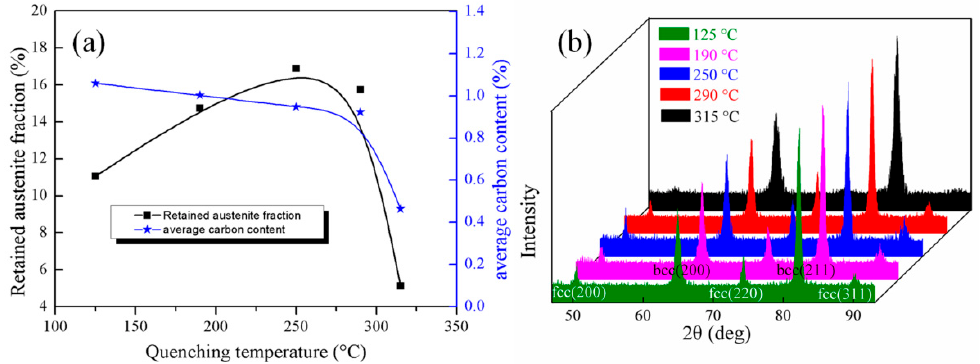
Figure 4. Retained austenite fractions and average carbon content under different quenching temperatures ( a ) and the corresponding X-ray diffraction patterns ( b ).